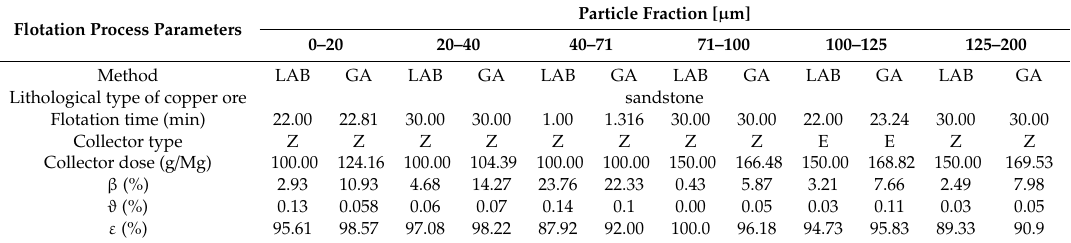
Table 16. The results obtained for the analysis of cases of all particle size fractions separately in the Denver flotation